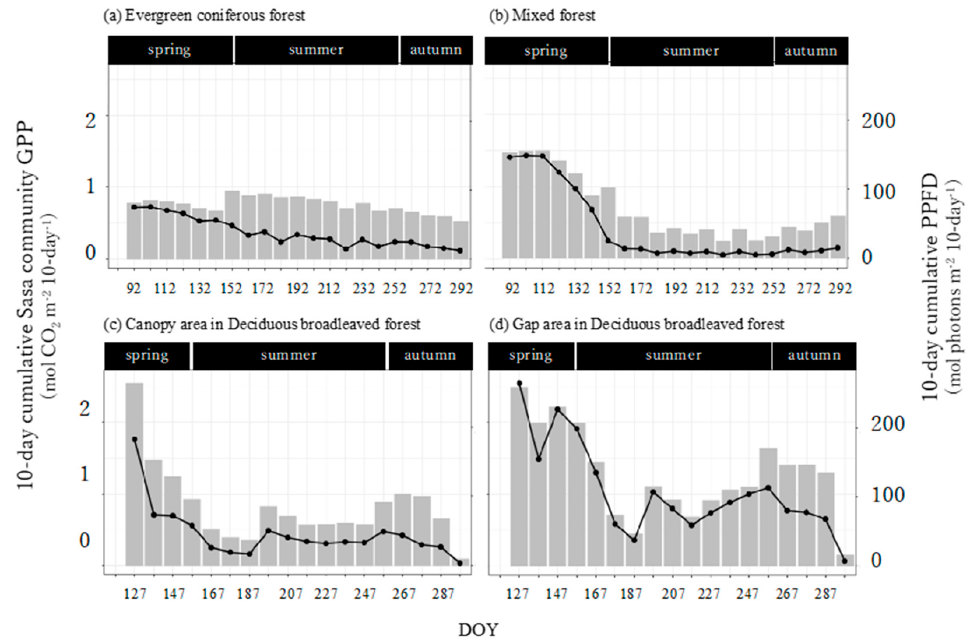
Figure 7. Seasonal trends of the 10-day cumulative Sasa community GPP (bars) and photosynthetic photon flux density (PPFD, lines) in the four sites. The 10-day cumulative Sasa community GPP and PPFD indicate integrated values of 10-day Sasa community GPP and PPFD.